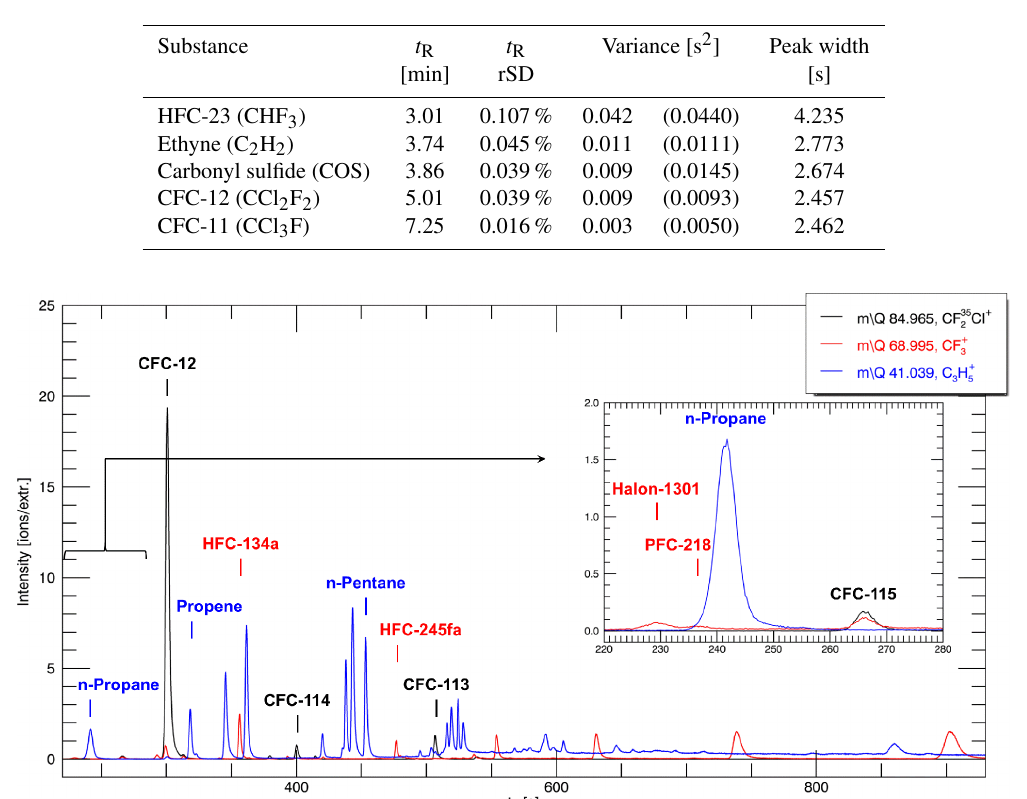
Table 4. Retention times t R with relative standard deviations rSD and variances for selected substances (same as Table 3) as well as their respective average signal width expressed as FWHM. Values derived as arithmetic means over four measurement series from different dates (April 2015 to June 2016), comprising 149 individual measurements ( ∼ 37 per series) of 19 different ambient air samples using the ramped GC programme. For retention time variance, maximum to minimum differences over the four measurement series are given in brackets. Trap adsorptive material: HayeSep D. HFC-23 is the first detectable substance, least separated by chromatography. CFC-11 can be considered a reference for optimal chromatographic performance of the given set-up.